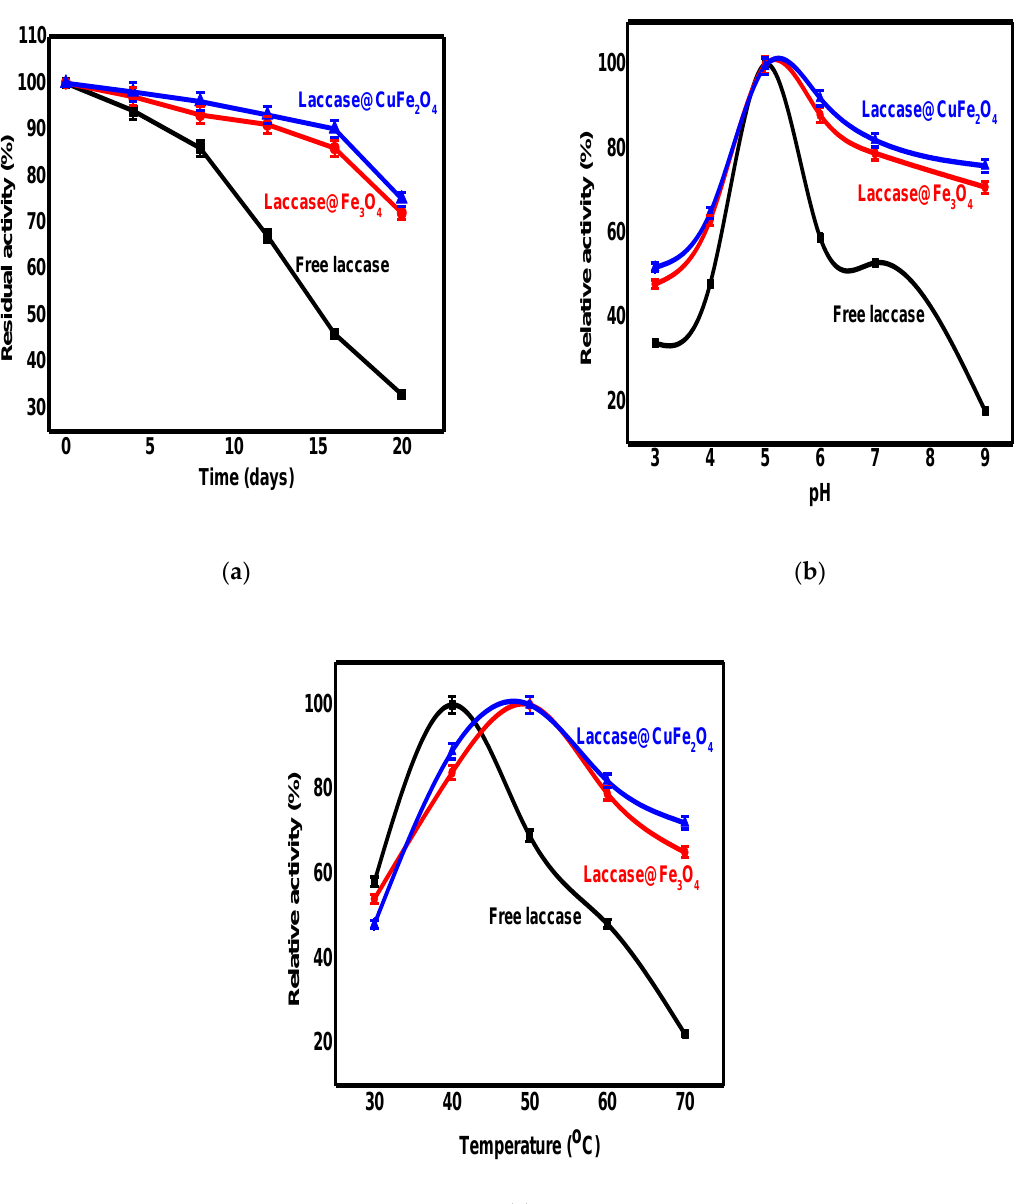
Figure 3. Storage stability ( a ), pH effect ( b ), and temperature effect ( c ) on free and immobilized laccase.